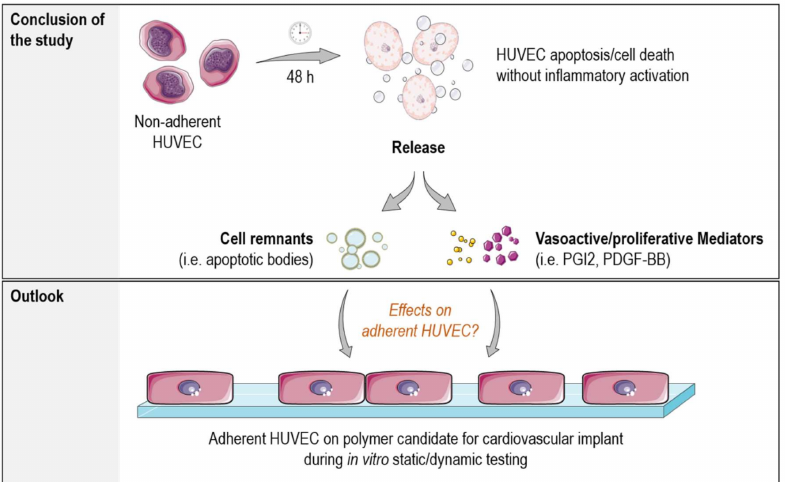
Figure 7. Illustration of the findings from the study. The study revealed that vasoactive and potentially proliferative acting mediators were released by the nonadherent HUVEC over time. There was no evidence for an inflammatory activation of HUVEC solely by cultivation under nonadherent conditions. Further studies will clarify whether mediators released and/or cell remnants from the apoptosis process can influence the surrounding environment and perhaps the endothelialization capacity of potential implant materials during in vitro static and dynamic testing (Picture modified from Servier Medical Art; Licence: CC BY 3.0;